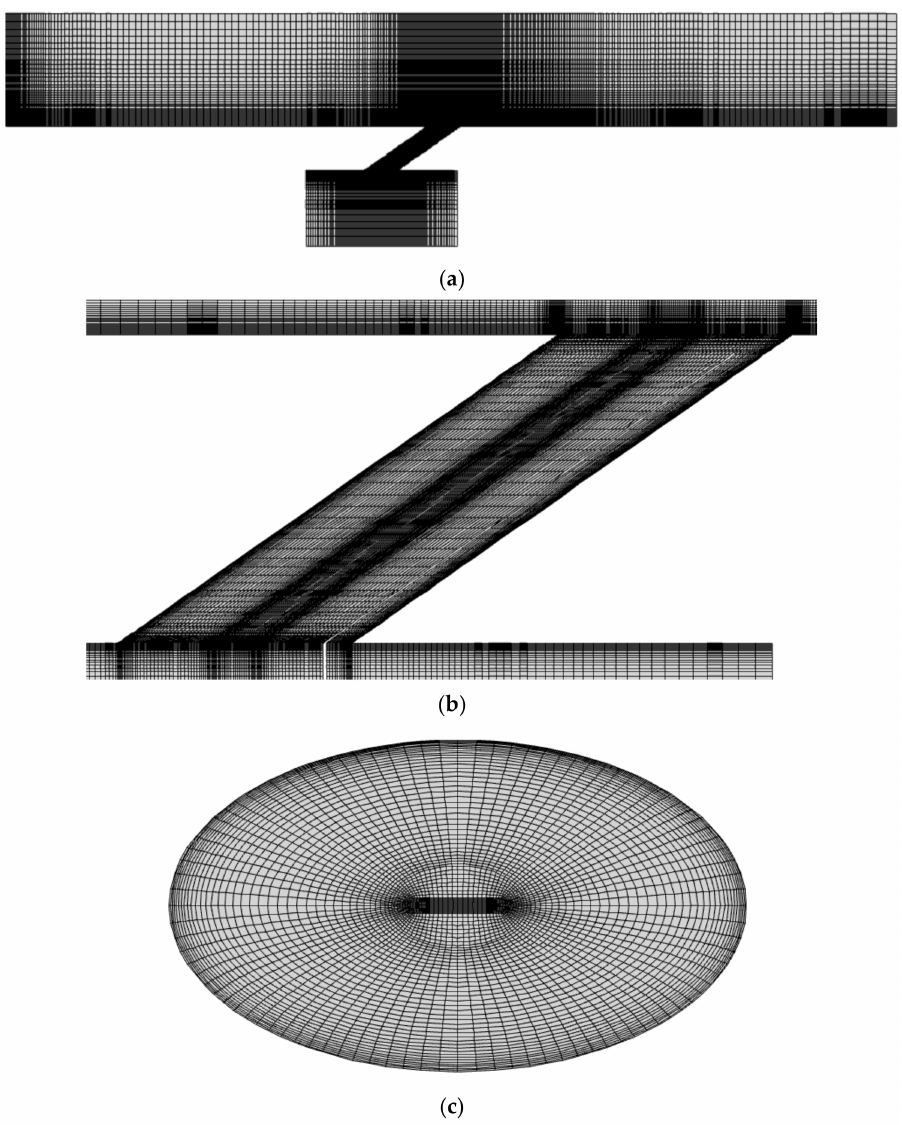
Figure 3. CFD meshes of the cylindrical hole: ( a ) overall view of the mesh on the z = 0 plane; ( b ) close-up of the grid around the hole; ( c ) Close-up of the grid at the hole